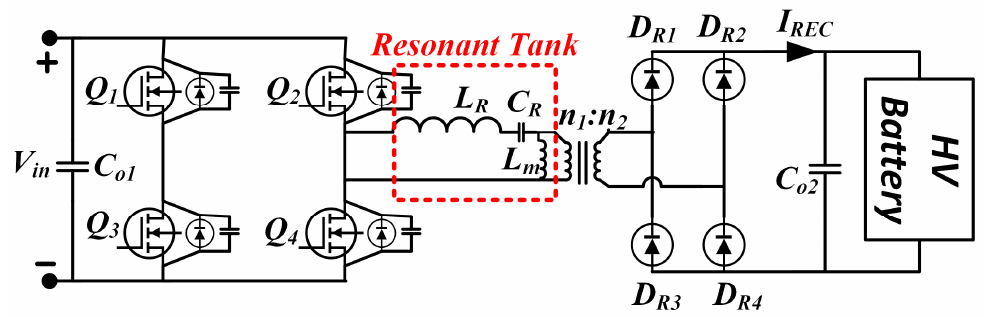
Figure 50. Full Bridge LLC Resonant Converter. Adapted from [46].